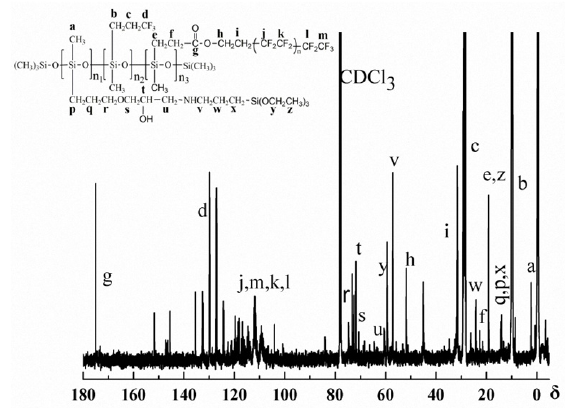
Figure 3. 13 C ‐ NMR of the PFAS.